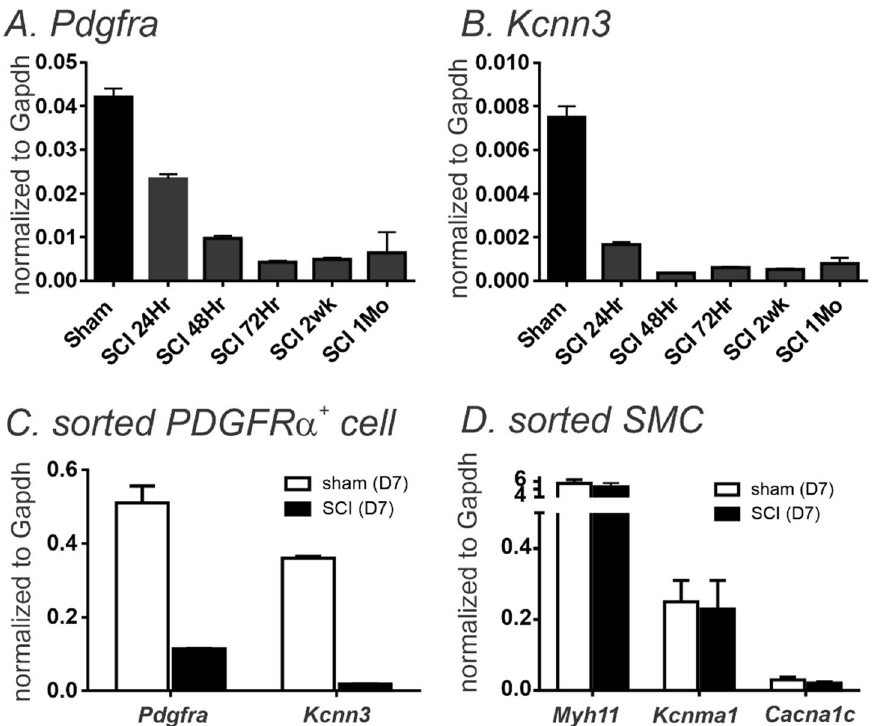
Figure 1. Quantitative analysis of transcripts in control and after SCI. (A,B) Pdgfra and Kcnn3 transcripts are decreased up to 1mo after SCI in detrusor muscles. ( C ) Transcripts of Pdgfra and Kcnn3 from sorted PDGFRα + cells in SCI (D7) decreased compared to control (D7). ( D) Transcripts including Myh11, Kcnma1 and Cacna1C from sorted SMCs showed no significant change in SCI (D3). Error bars denote standard deviation from n =